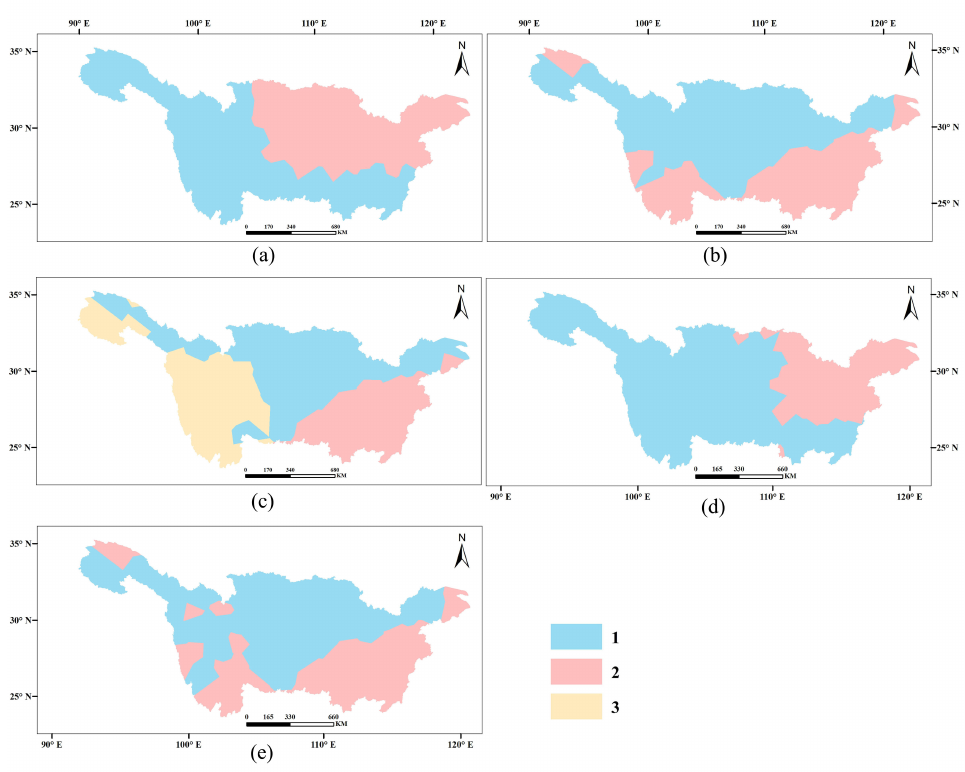
Figure 10. Result of time series clustering analysis. ( a ) Spring; ( b ) summer; ( c ) autumn; and ( d ) winter; ( e )